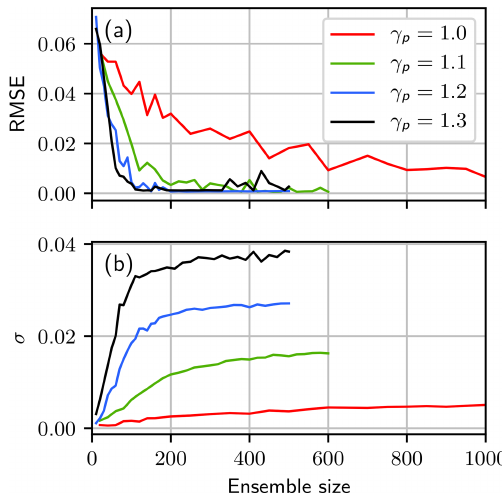
Figure 10. The RMSE and the standard deviation of the water con- tent at the last observation time (160h), averaged over the 40 dif- ferent realizations. The RMSE is calculated between the truth and the estimated mean. Both quantities are shown for varying factors of γ p (Eq. 14): γ p = 1 . 0 (red line), γ p = 1 . 1 (green line), γ p = 1 . 2 (blue line) and γ p = 1 . 3 (black line). Note the different scaling of the x